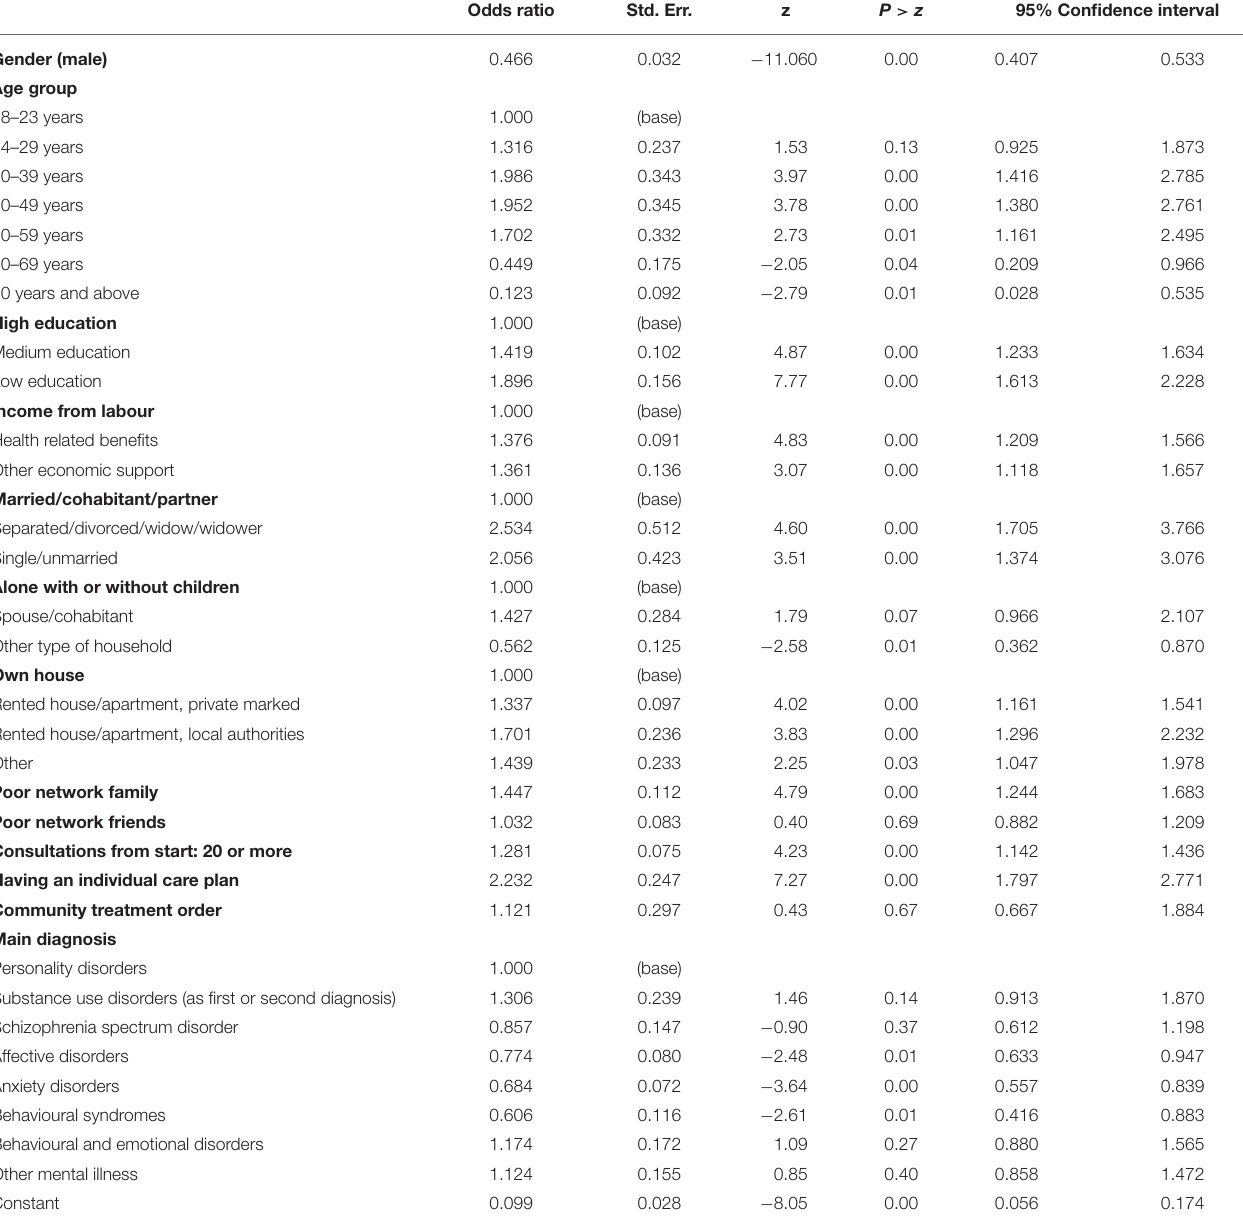
TABLE 7 | Logit regression of the association between patient characteristics and whether minor children of outpatients ( N = 6634)* are being referred. Odds ratio Std. Err. z P > z 95% Confidence